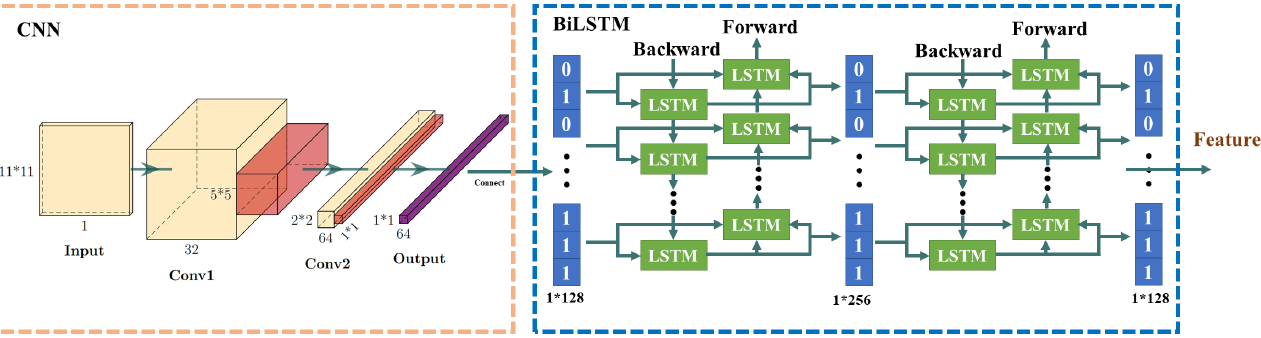
Figure 6. The CNN-BiLSTM feature extraction